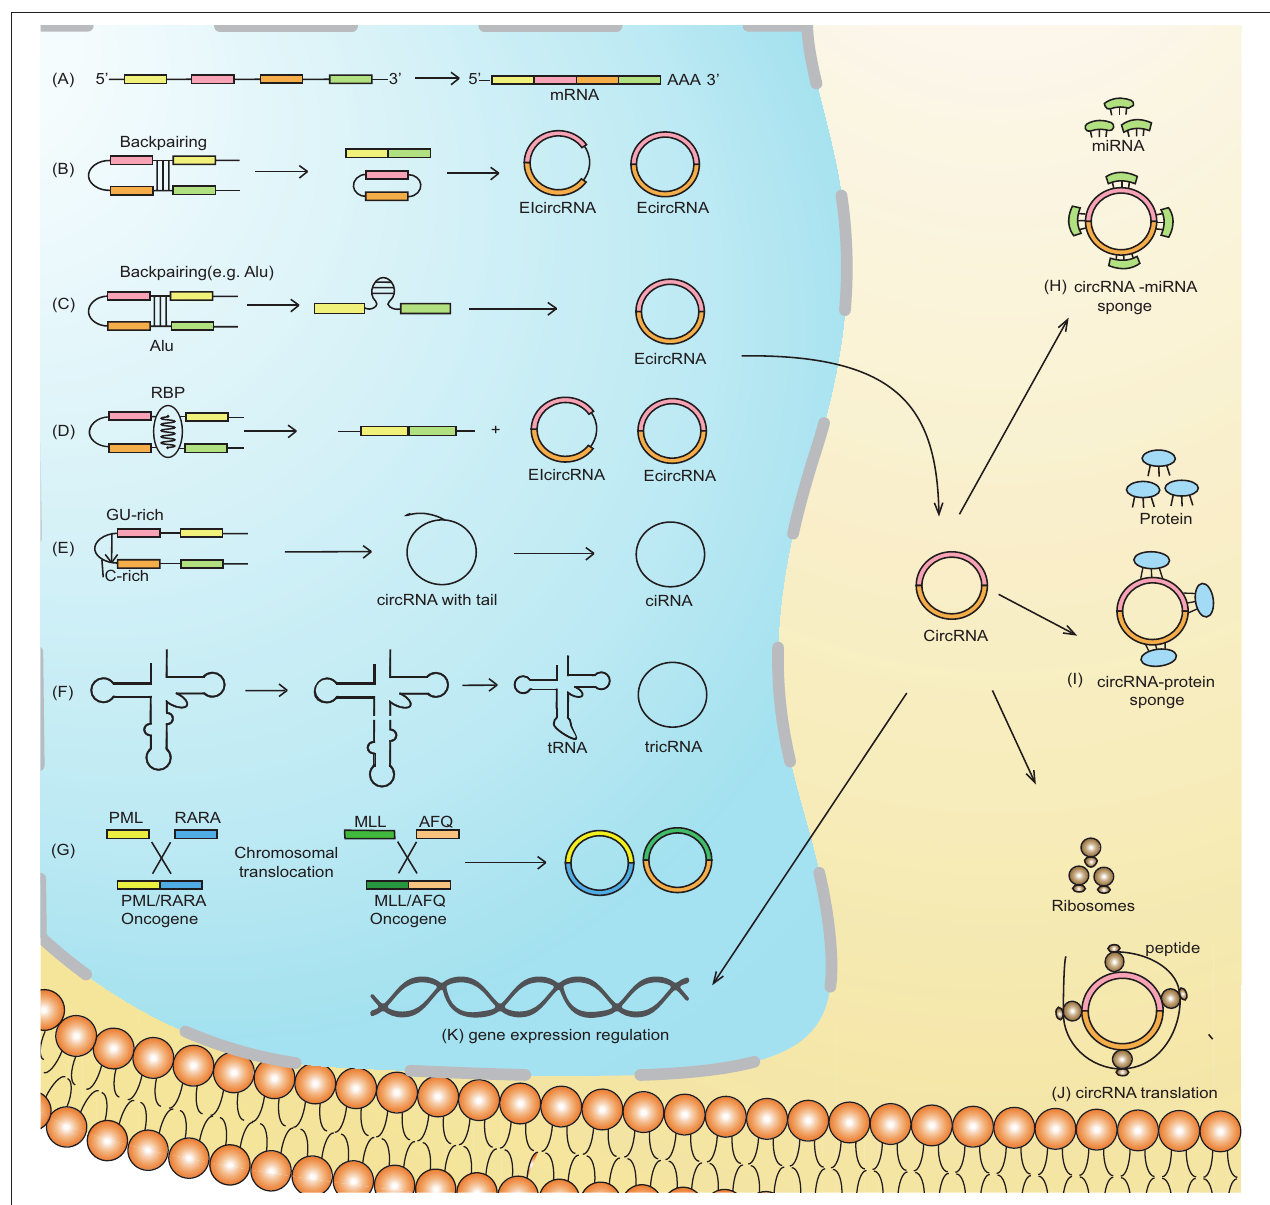
FIGURE 1 | Schematic representation of circRNA biogenesis. (A) Canonical pre-mRNA producing a mature mRNA. (B) Lariat-driven circularization, also called exon-skipping, is a process in which the partial folding of pre-mRNA allows the covalent binding of the exonic 5 ′ -splice donor site with the 3 ′ -end acceptor site, thus resulting in the skipping of exons. (C) Intron-pairing-driven circularization is characterized by base-pairing between different repetitive elements such as Alu repeats across different introns. The intronic sequence is subsequently cleaved to produce exonic circRNA (ecircRNA). (D) RNA-binding proteins (RBP) working as trans -acting factors vitally regulate the production of circRNA. Quaking (QKI) and Muscleblind (MBL/MBNL1) proteins preferentially bind to a particular sequence motif on a linear RNA, thus bridging the two bracketing introns together and circularizing the linear RNA to generate circRNA. (E) A novel circRNA known as ciRNA is dependent on a 7-nt GU-rich motif and an 11-nt C-rich sequence near the 5 ′ -splice site and branchpoint site. The lariat structure containing the excised intron and exons is trimmed by the spliceosome followed by the degradation of the 3 ′ -end tail, ultimately generating ciRNA. (F) tRNA intronic circular RNAs (tricRNAs) are produced as a product of the splicing of tRNA independent of pre-mRNAs, which is catalyzed by an enzyme in a presence of conserved tRNA sequence motif. (G) Chromosomal translocation results in the fusion of two genes producing fusion circRNA (f-circRNA). Functions of circRNA: (H) circRNAs may act as miRNA sponges by competing for miRNA binding sites, diminishing the effect of miRNA-mediated regulatory activities. (I) cricRNA may acts as protein (RNA binding protein), which regulate gene expression and are thus involved in various biological processes (J) circRNAs can be translated to form functional proteins, e.g., ribosome-associated circRNAs (ribo-circRNAs) harbor start codon and evolutionarily conserved stop codon encoding at least in protein domain circRNAs. (K) c ircRNAs (e.g., EIciRNAs and ciRNAs) may interact with transcription complexes and enhance the expression of their parental genes. Moreover, some of the nuclear enriched circRNAs may bind with the genomic DNA, forming an RNA-DNA triplex that can regulate the DNA replication process.